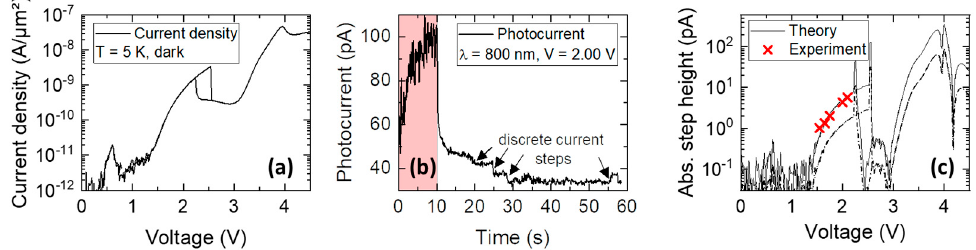
Figure 3. ( a ) Current density-voltage characteristic of an RTD-SPD with a 10 nm thick quantum well. Three resonances can be observed. ( b ) Background-corrected photocurrent taken at V = 2.00 V. The red highlighted region marks the time when the laser was on (light power of 100 fW). During this time, the large fluctuations in the photocurrent indicate multiple photon detection events that are merged because of the time resolution of the setup. ( c ) Theoretical and experimental determination of the step height of a single charging event versus voltage. As the voltage is increasing, the current step height increases as well due to the increase in the differential conductance.